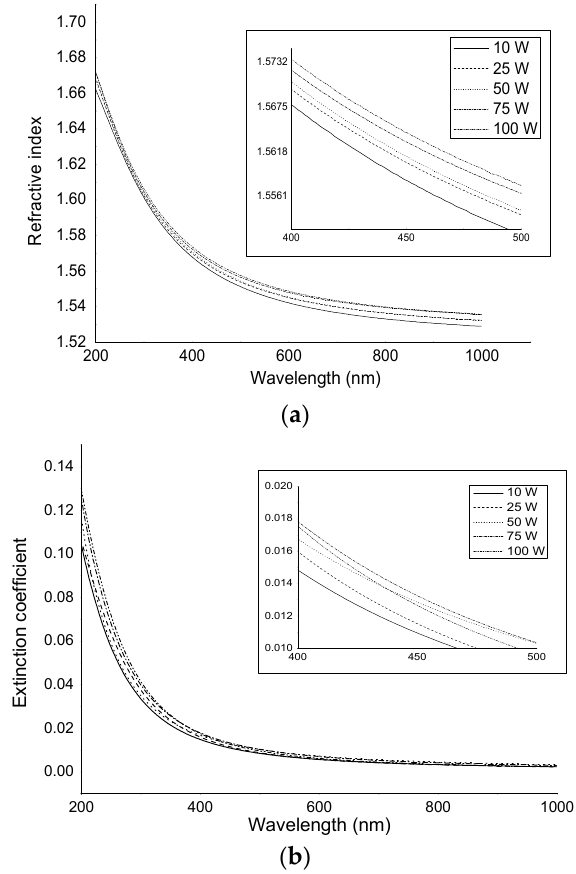
Figure 3. Optical constants of geranium oil-derived polymer films fabricated at various deposition powers; ( a ) Refractive index; ( b ) Extinction coefficient.